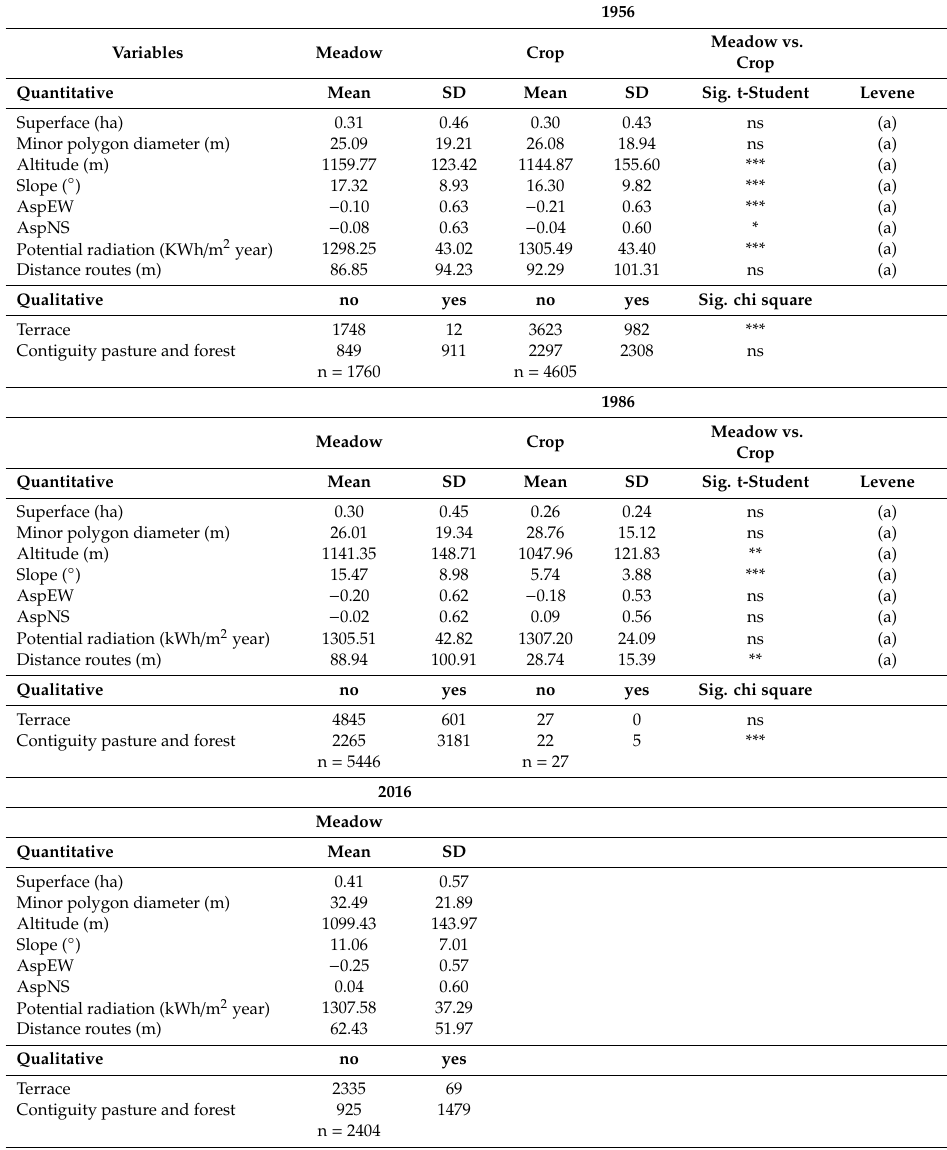
Table 2. Characteristics and comparison of the meadow and crop parcels of 1956 and 1986 and the 2016 meadow. t-Student test for the quantitative variables and chi square for the qualitative variables between the meadow and crop parcels in 1956 and 1986 (n = number of the